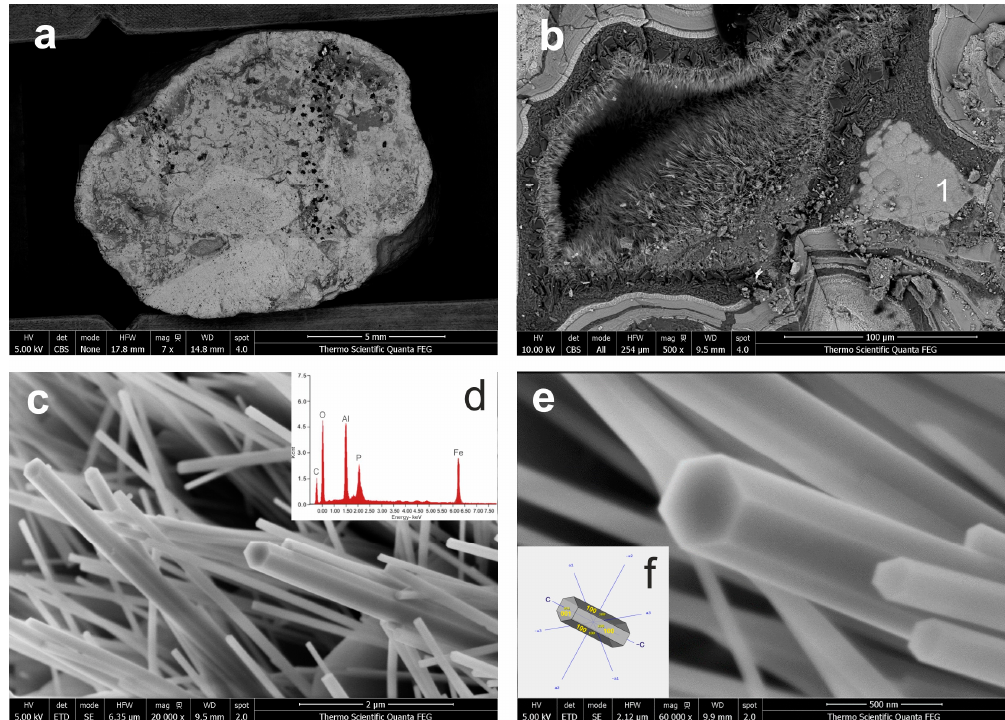
Figure 6. Cacoxenite crystals in goethite pisolith: ( a ) SEM micrograph of the pisolith – light gray color shows the pure goethite part; ( b ) needle-shaped crystals in vug; ( c ) bundles of cacoxenite; ( d ) EDX spectrum of crystals; ( e ) hexagonal crystals; ( f ) crystal habit of cacoxenite crystals with their faces denominated in the common notation of Miller´s indices. 1 – botryoidal goethite surface.